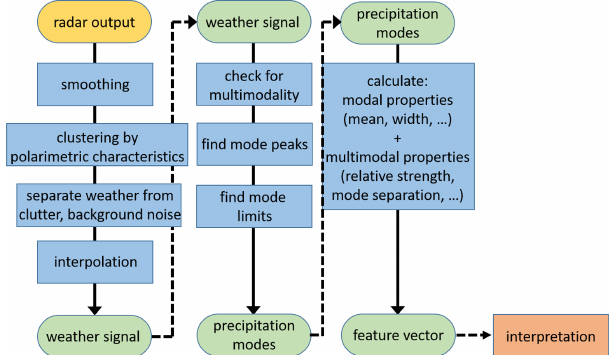
Figure 2. Outline of the proposed spectral postprocessing method. First, the weather signal is isolated from the non-meteorological contributions to the Doppler spectra (Sect. 2.2). Then, the precip- itation modes are identified at each height (Sect. 2.3). Finally, quan- titative characteristics of the precipitation modes are calculated, in- cluding uncertainty estimates, and can be collected in a feature vec- tor to analyze the observed precipitation event (Sect.